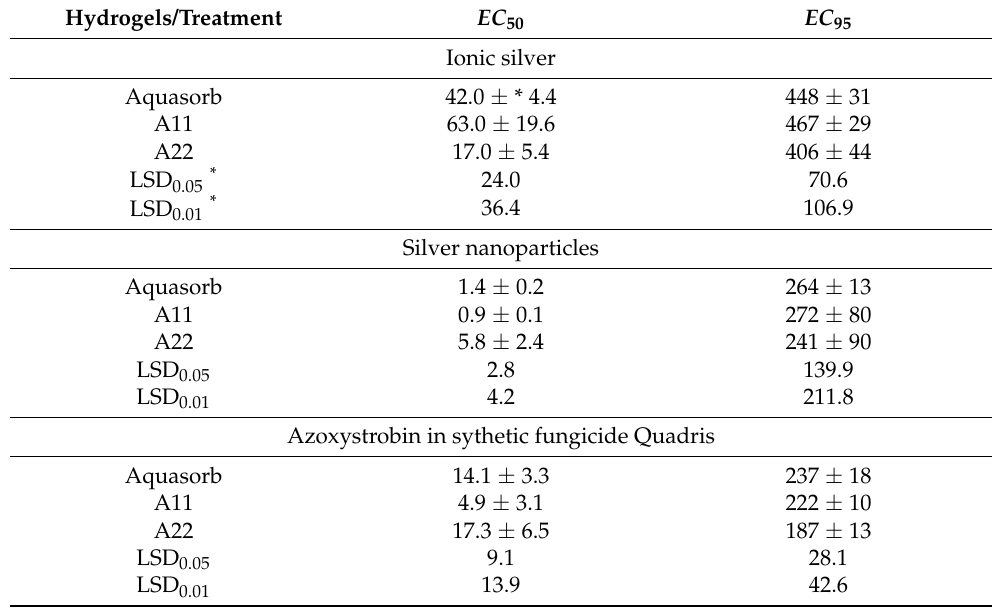
Figure 6. Quantitative approach to the EC 50 and EC 95 assessment according [3] (explanations in the text). Table 4. The effective concentration for two-fold and total suppression of late blight growth.